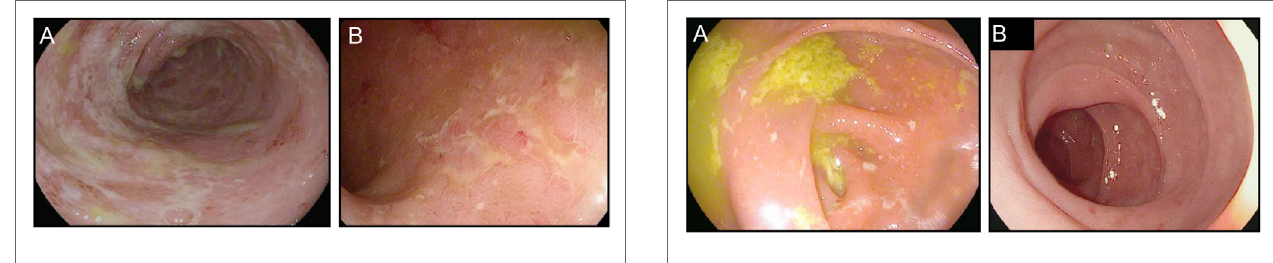
FiGURe 1 | Ipilimumab colitis endoscopically resembles ulcerative colitis. (a,B) High resolution photograph of the colon of a patient with ipilimumab- associated colitis (a) or with ulcerative colitis (B) .